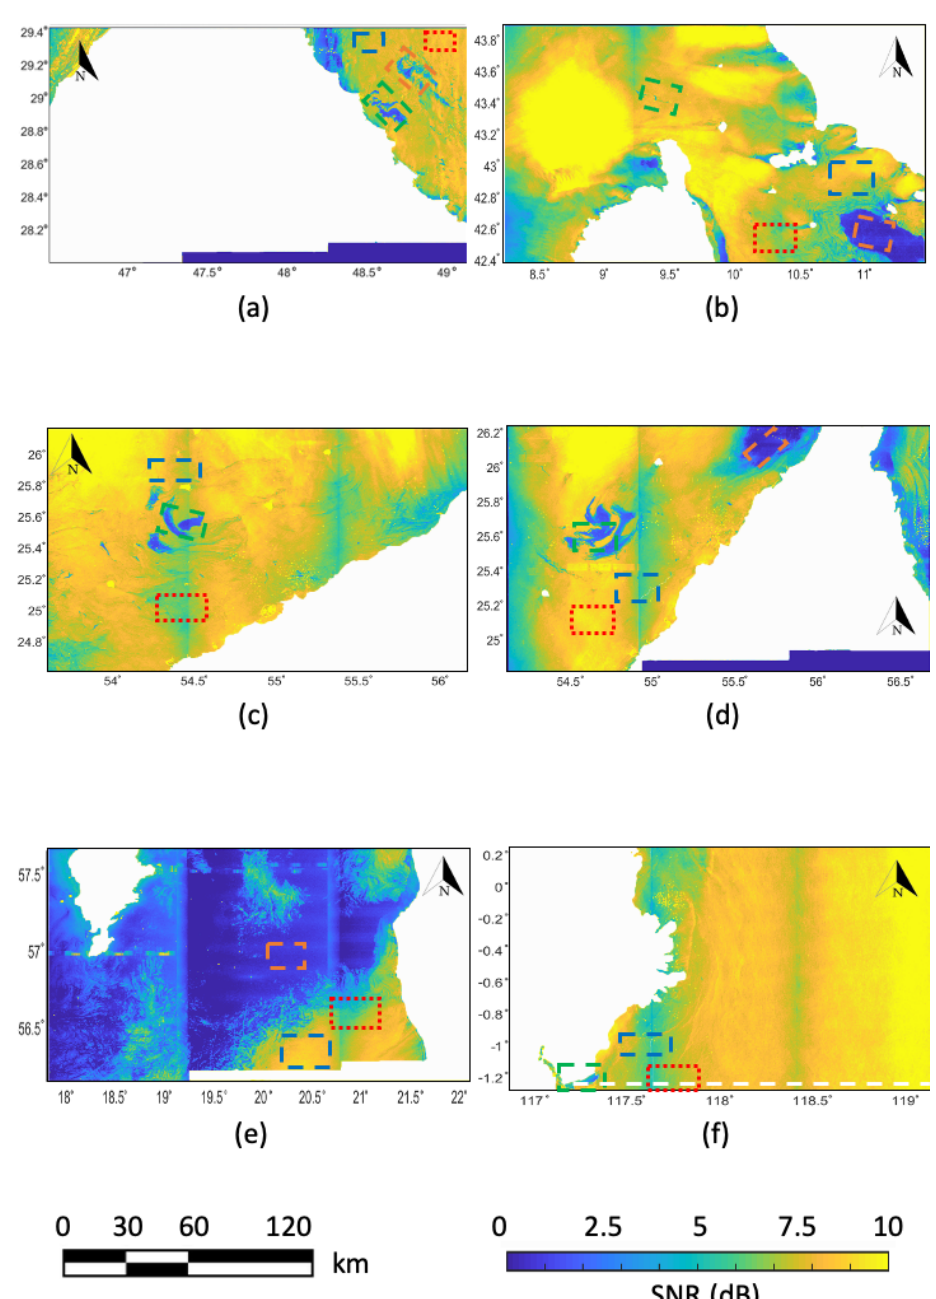
Figure 3. SNR images, in dB scale, evaluated over the SAR dataset shown in Figure 2. ( a – f ) refer to the SAR scenes labeled as data ID 1–6 in Table 1. Land is masked in